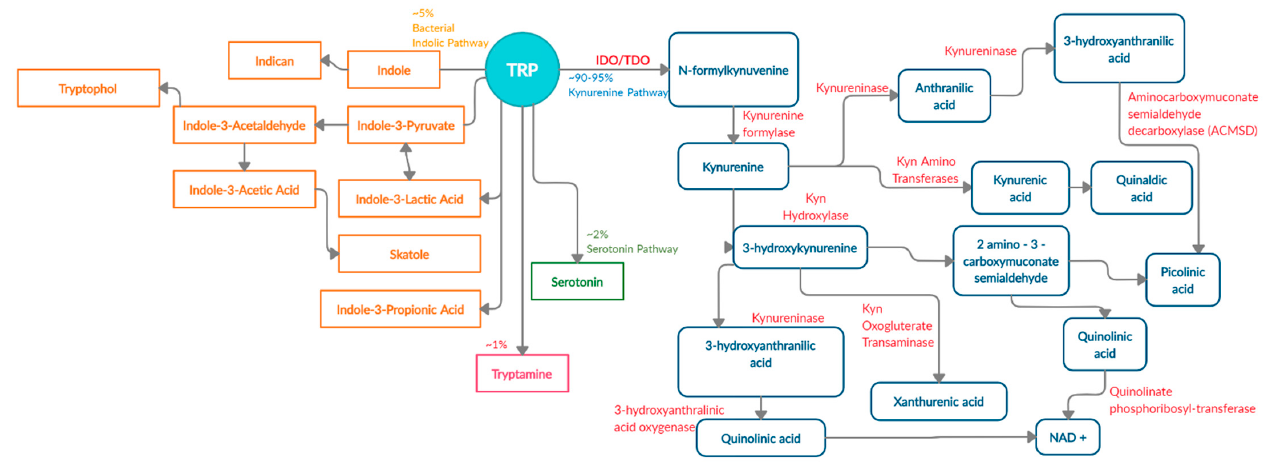
Figure 1. Schematic representation of enzymes and metabolites in the Trp-Kyn pathway. 3. The Kynurenine Pathway Is the Major Tryptophan Degradation Pathway